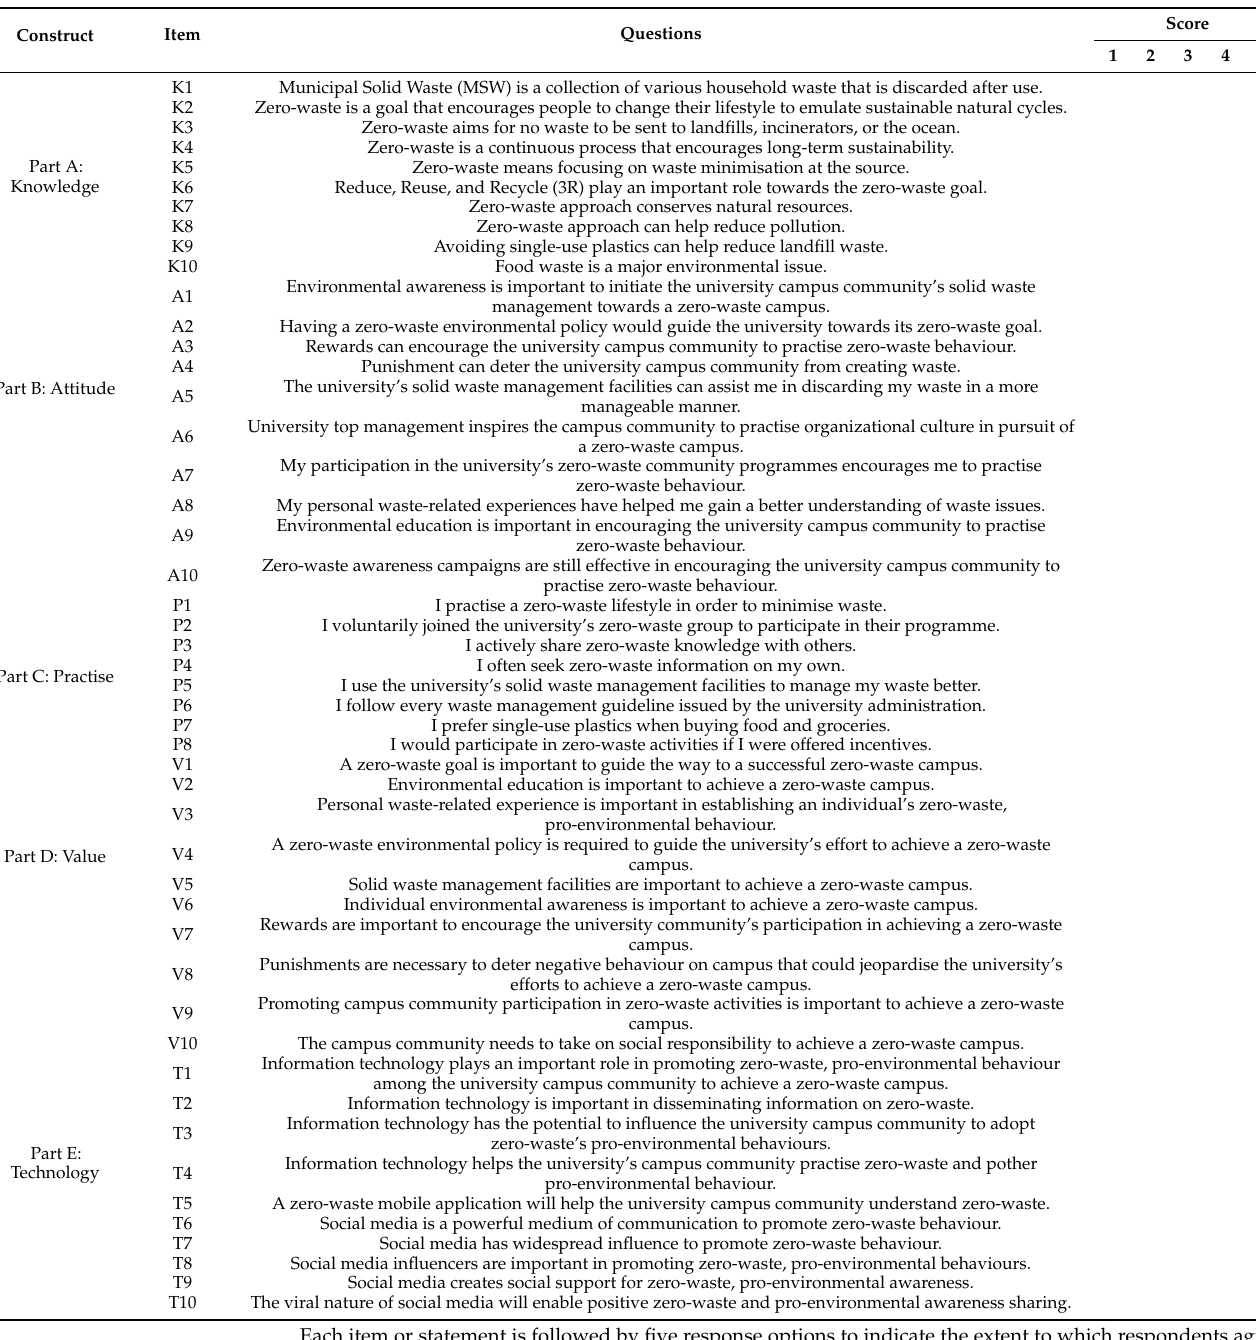
Table A1. Zero-Waste Campus Questionnaire